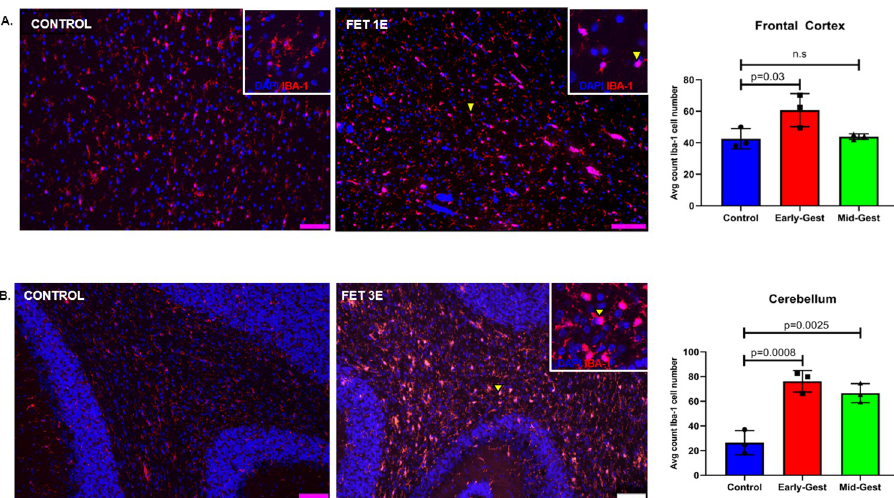
Fig 7. Immunofluorescence (IF) for neuroinflammatory marker for microglia (Iba-1) in the frontal cortex ( A ), and cerebellum ( B ) of control and ZIKV fetuses. In the white matter of the frontal cortex ( A ), significant increase in Iba-1 + reactive microglial cell (arrow and inset) population was observed in the early but not in fetal brains from mid- gestation ZIKV inoculated dams compared to controls. Microglial cells undergo morphological changes from resting to reactive state. Microglia in brains from control fetuses mostly appear in resting state (arrow, inset) where Iba-1 staining is seen concentrated in the neuronal processes which are more ramified compared to reactive or activated microglia in the brains from fetuses from ZIKV inoculated dams (arrow, inset) which are unramified with a larger cell body in an amoeboid shape where Iba-1 staining is most concentrated. Fetal cerebellum from both early and mid- gestation inoculated dams ( B ) had significantly more Iba-1+ reactive microglia (arrow and inset) in the granular layer compared to control brains (Scale bar = 50 μ m; Error bars depict SD, Dunnett’s multiple comparison test was done for statistical analysis, p < 0.05 considered significant, n.s,